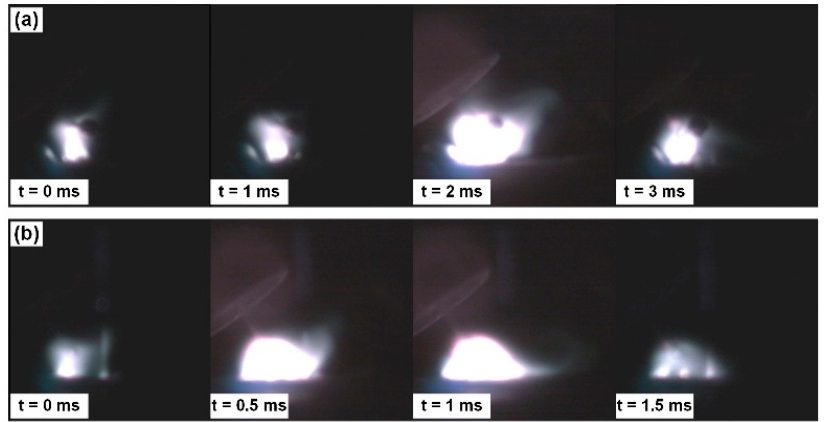
Figure 3. Plasma shape obtained by high-speed camera; ( a ) arc welding and ( b ) laser-arc hybrid welding for weld #3.